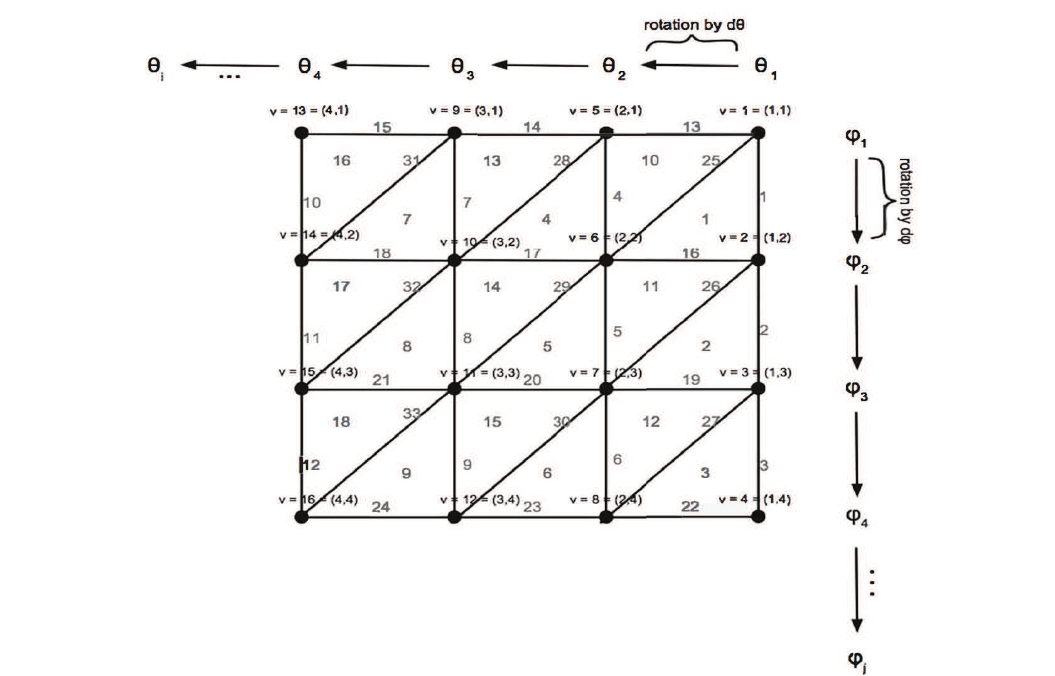
Figure 1. Example triangulation where the index i corresponds with the polar angle θ , and the index j corresponds with the azimuthal angle φ . Vertices are indexed as ( i , j ) or as the single digit v , given by v = j + ( i − 1 ) N φ . The numbers of points sampled along the directions are given by the notation N θ or N φ . The increments of angles are computed by (cid:52) θ = π − 2 ε